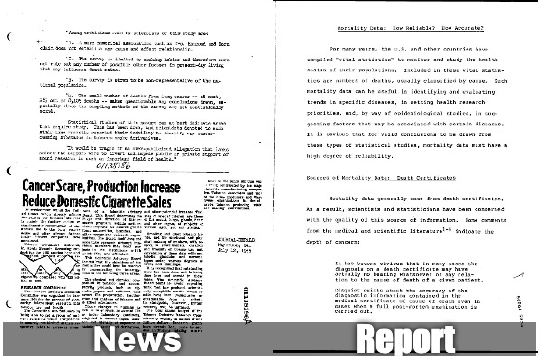
Figure 12. The sample image inputs from two classes News and Report. As we can see from the two images, the image of News matches the image from Report to a greater extent in visual